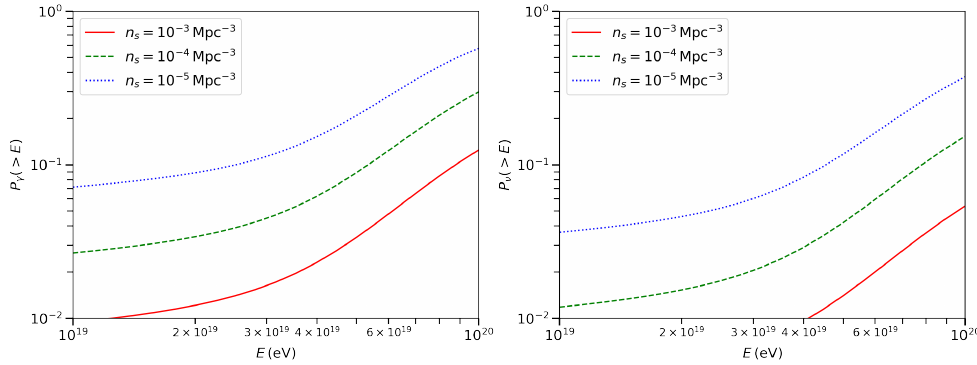
Figure 3. Average detection probability for gamma-ray/neutrino sources toward UHECR directions as a function of the lower limit of the cosmic ray energy. Left panel: observation of >2 TeV gamma-rays. Right panel: observation of >100 TeV neutrinos. The three lines correspond to three source number densities, 10 − 3 , 10 − 4 , and 10 − 5 Mpc − 3 . The sensitivity is assumed to be ¯ f th = 10 − 12 ergcm − 2 s − 1 for both gamma-ray and neutrino